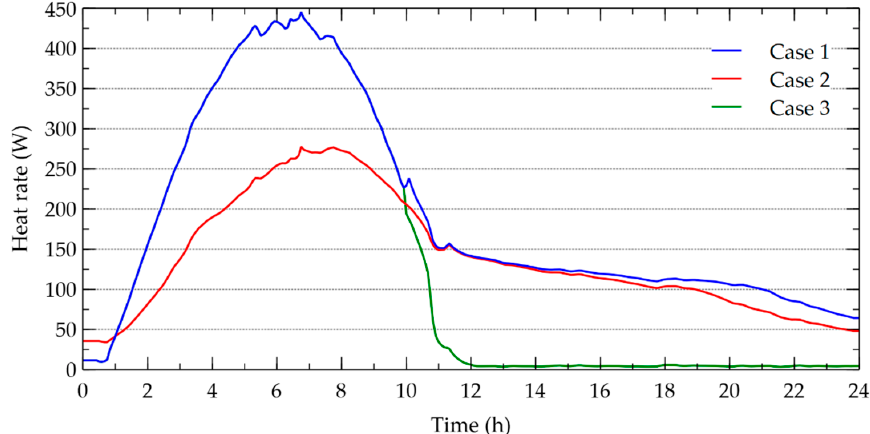
Figure 11. Estimated temperatures of components in case 3.